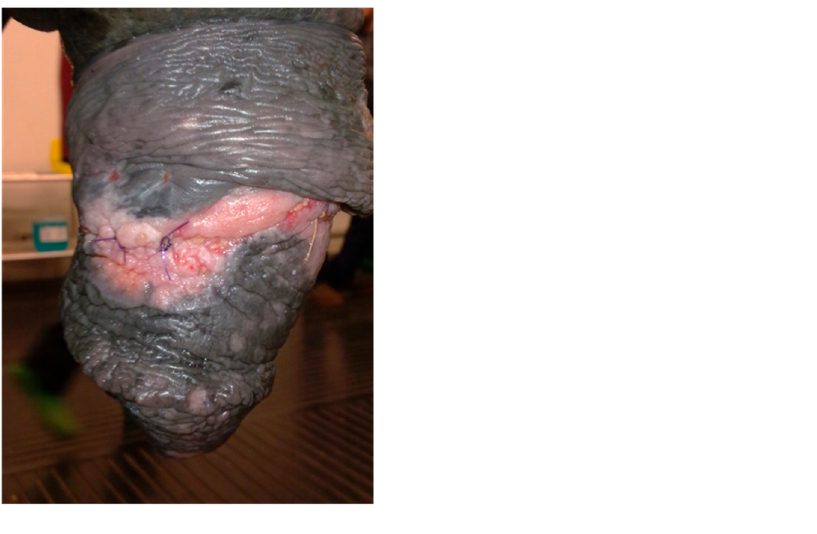
Figure 17. Penile/preputial wound after segmental posthetomy and reconstruction (clinical case